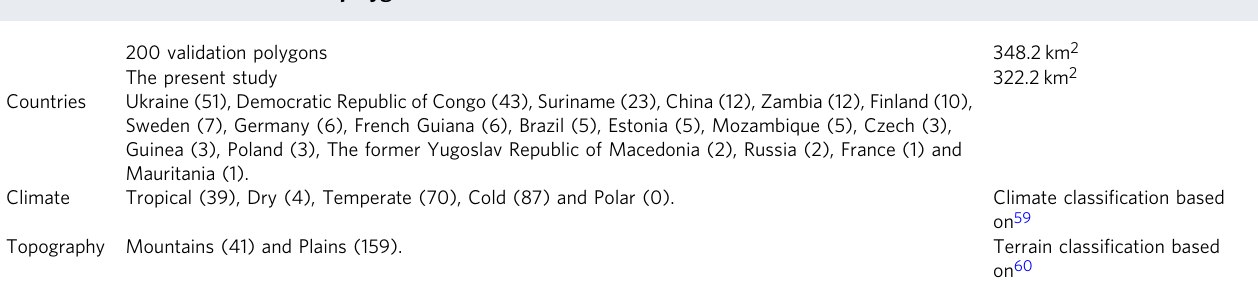
Table 4 Distribution of validation